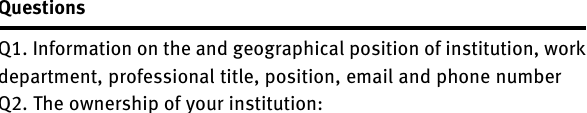
Table  : General information on institution and personnel. Questions